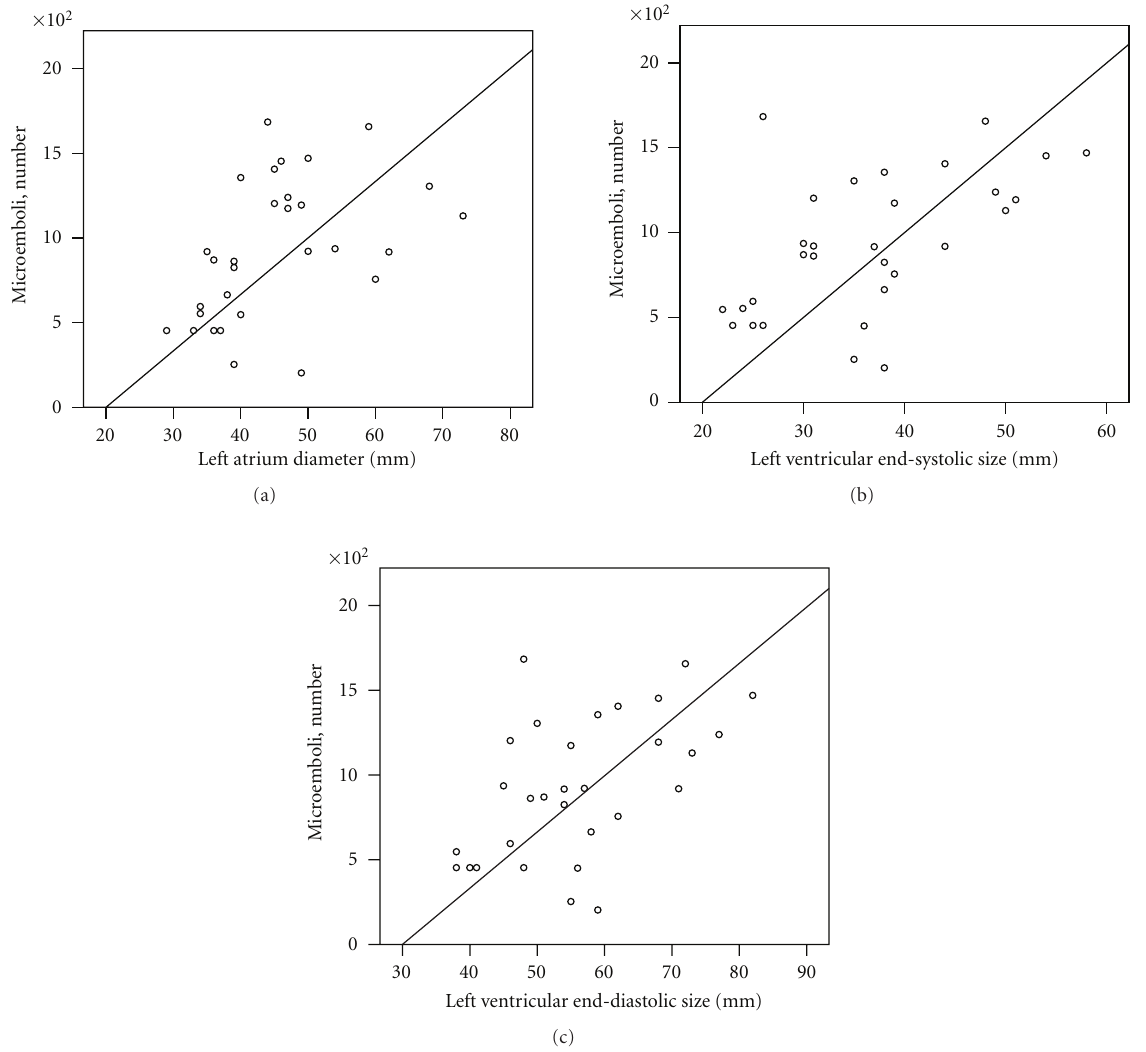
Figure 1: Left cardiac chambers size and microembolic load in open heart operations ( r s = 0 . 48 − 0.57, P s < 0 . 01). (a) Left atrium diameter; (b) left ventricular end-systolic diameter; (c) left ventricular end-diastolic diameter.